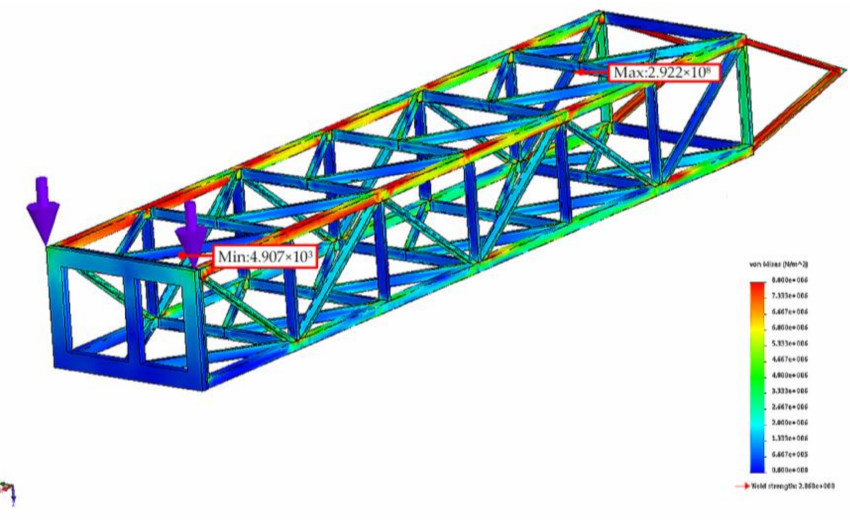
Figure 25. von Misses stress of the BWE boom based on the static